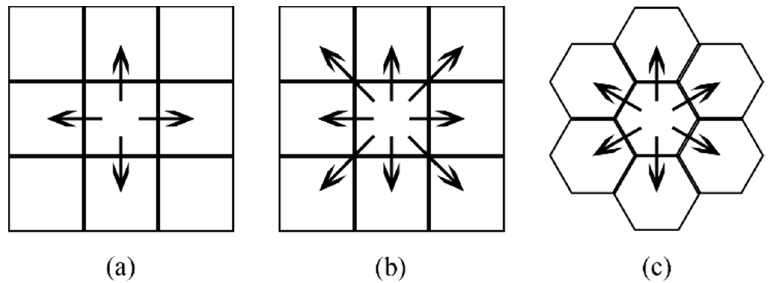
Figure 1. Propagation directions. ( a ) Four directions ( b ) Eight directions ( c ) Six